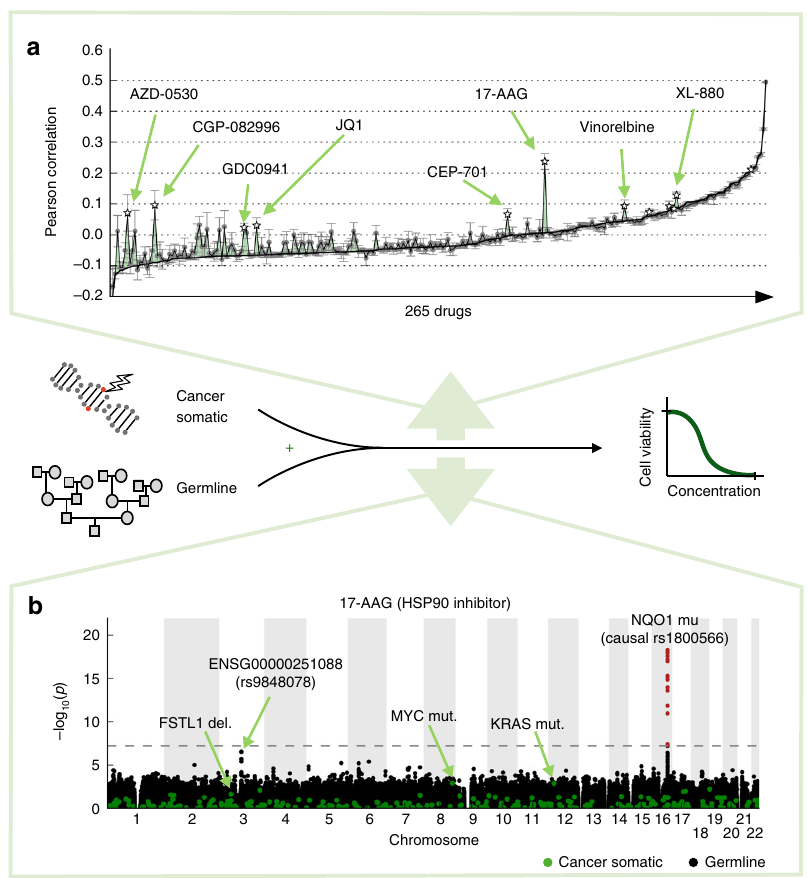
Fig. 1 Illustration of the joint analysis approach considering germline variants and somatic mutations. a Prediction of drug susceptibility, either exclusively considering somatic mutations (baseline, black line) or considering the combination of germline variants and somatic mutations (green). Shown is out-of- sample prediction performance measured by the Pearson correlation coef fi cient between predicted and observed drug susceptibility pro fi les (quanti fi ed as 1-AUC; Methods). Error bars show standard deviations across analysis repetitions of the difference of Pearson correlation coef fi cients from the compared models (Methods, Supplementary Note 1). Selected drugs with large improvements of prediction performance when accounting for germline variants are highlighted. b Illustration of a joint genome-wide association analysis, considering associations between somatic mutations (green) or germline variants (black) and drug susceptibility for 17-AAG. Germline variants with genome-wide signi fi cant associations are highlighted in red (FWER < 0.05, dashed horizontal